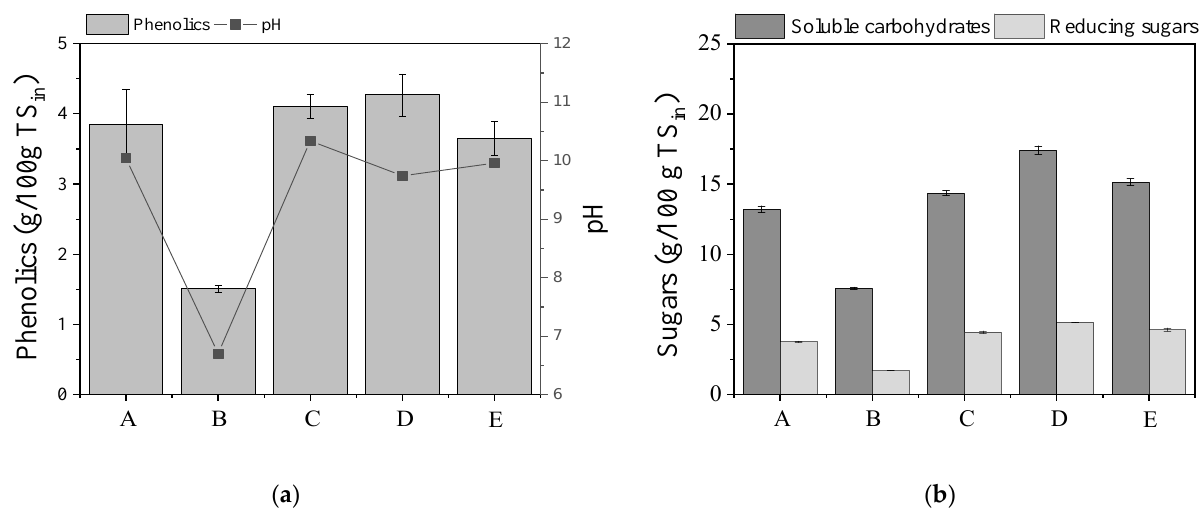
Figure 2. ( a ) Phenolic compound concentration expressed as g/100g TS in (in: initial biomass) (left axis) and pH (right axis). ( b ) Soluble carbohydrates and reducing sugars in the slurries from the different pretreatment approaches. (A) NaOH (0.5% w / v ), (B) H 2 O 2 (0.5% v / v ), (C) mixture of NaOH (0.5% w / v ) and H 2 O 2 (0.5% v / v ) at ratio 1:1, (D) initially NaOH (0.5% w / v ) followed by H 2 O 2 (0.5% v / v ), and (E) initially H 2 O 2 (0.5% v / v ) followed by NaOH (0.5% w / v ).